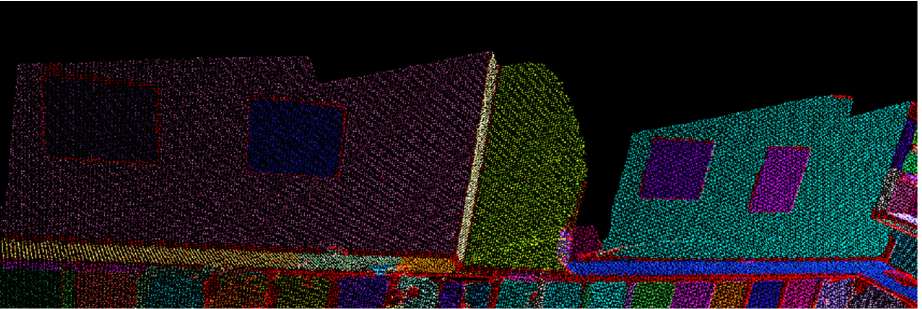
Figure 2. Segmentation plane point cloud.